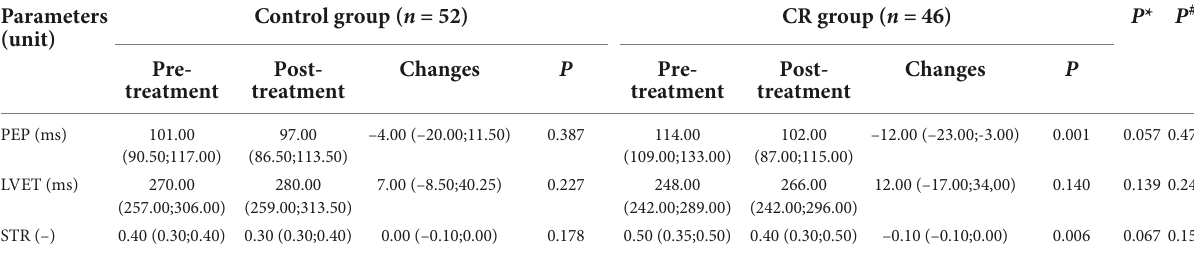
TABLE 8 Comparison of afterload parameters measured by impedance cardiography of patients with CHD and AHF before and after the treatment. Parameters (unit) Control group (n = 52) Pre-treatment Post- Changes P Pre-treatment Post- Changes treatment treatment SSVR (dynes/cm 5 /beat)